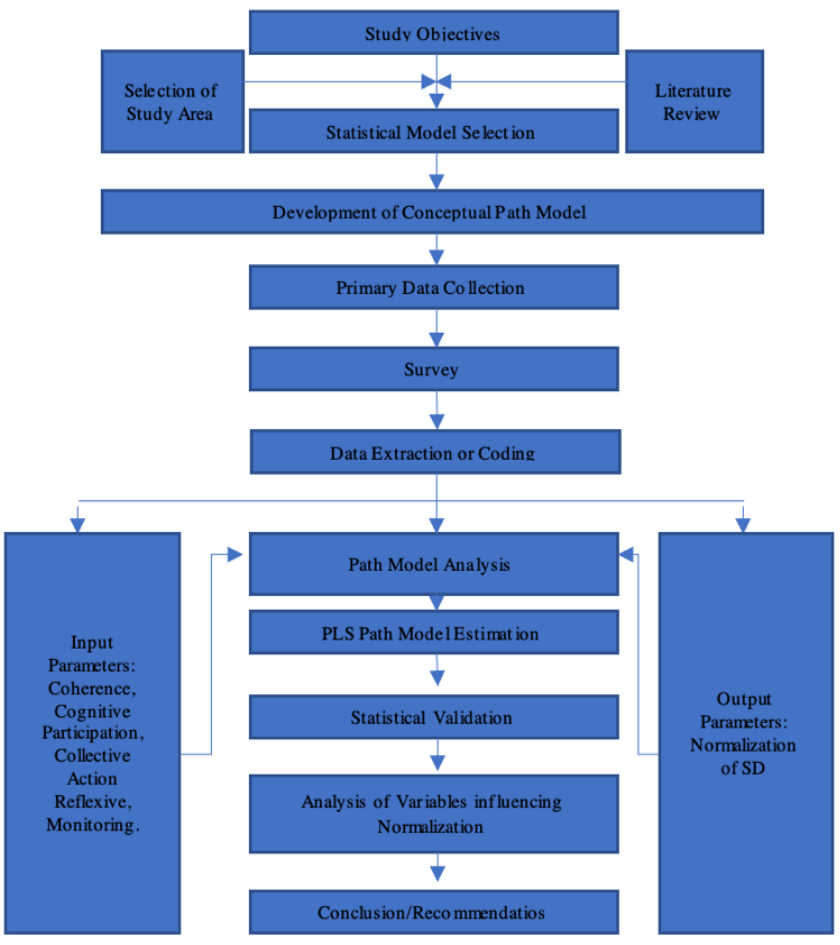
Figure 3. Conceptual framework.